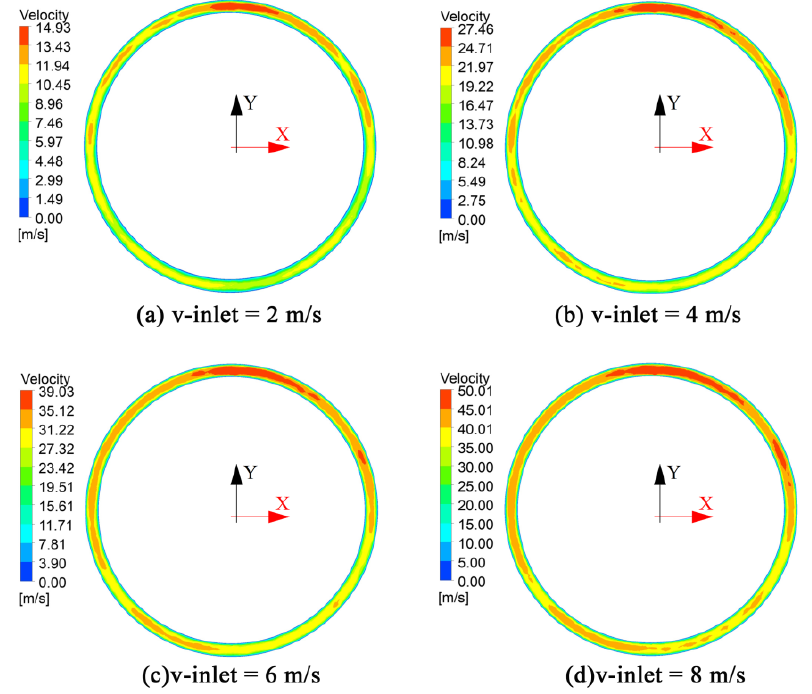
Figure 5. Distribution of gas flow velocity at the gas outlet boundary of the single gas chamber die.